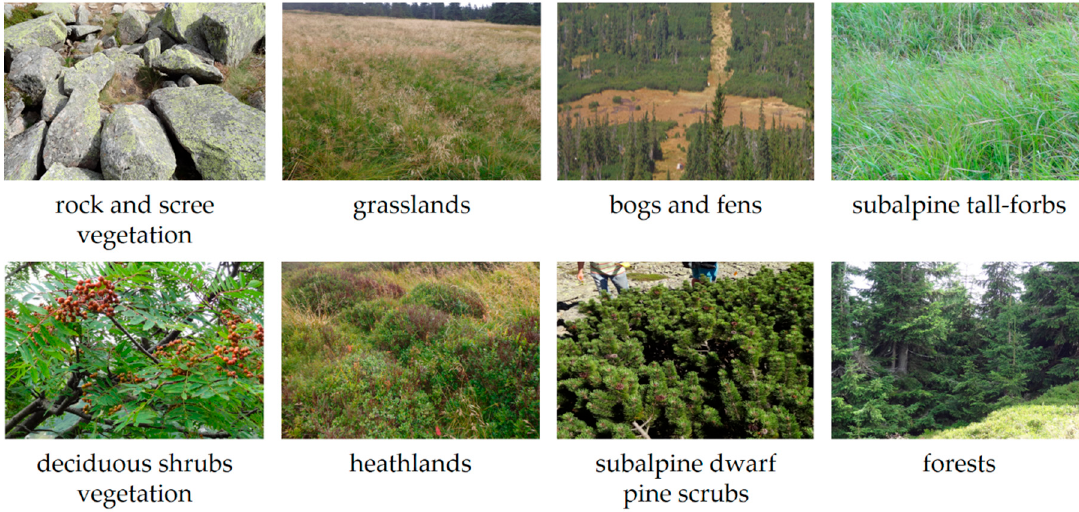
Figure 2. Giant Mountains vegetation types (photos by A. Marcinkowska-Ochtyra, adapted from [51]).